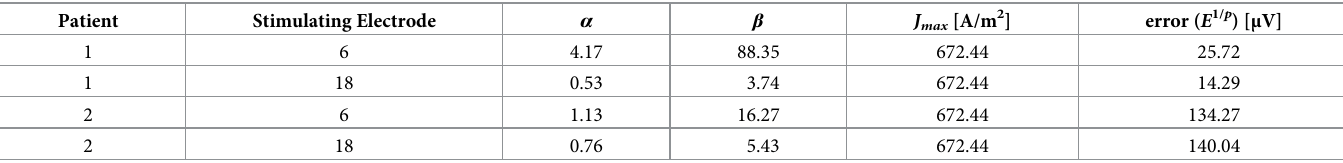
Table 1. Parameters obtained after the optimization corresponding to first test of the Results section (Fig 10).